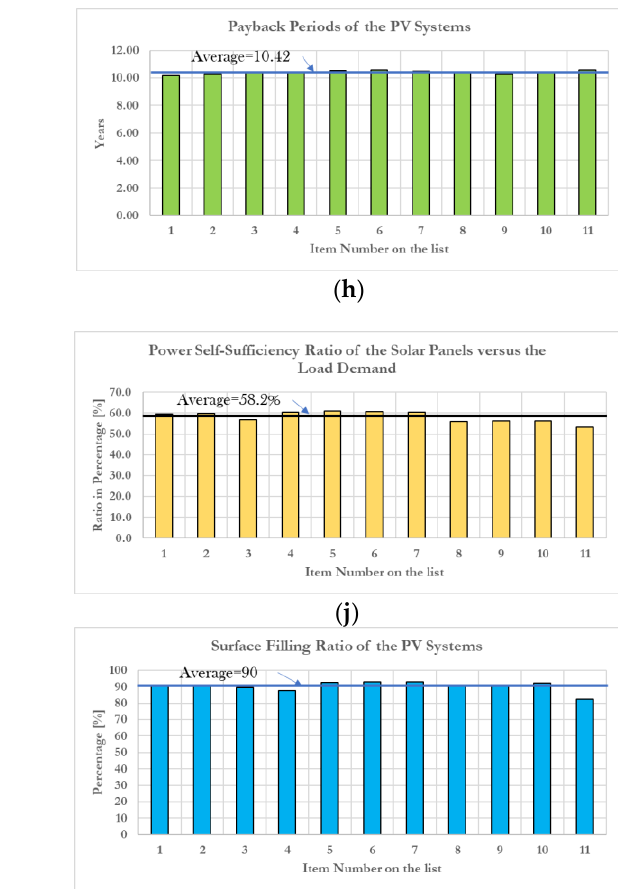
Table 3. Decision matrix used for our proposed rank-weigh-rank (RWR) optimization algorithm.